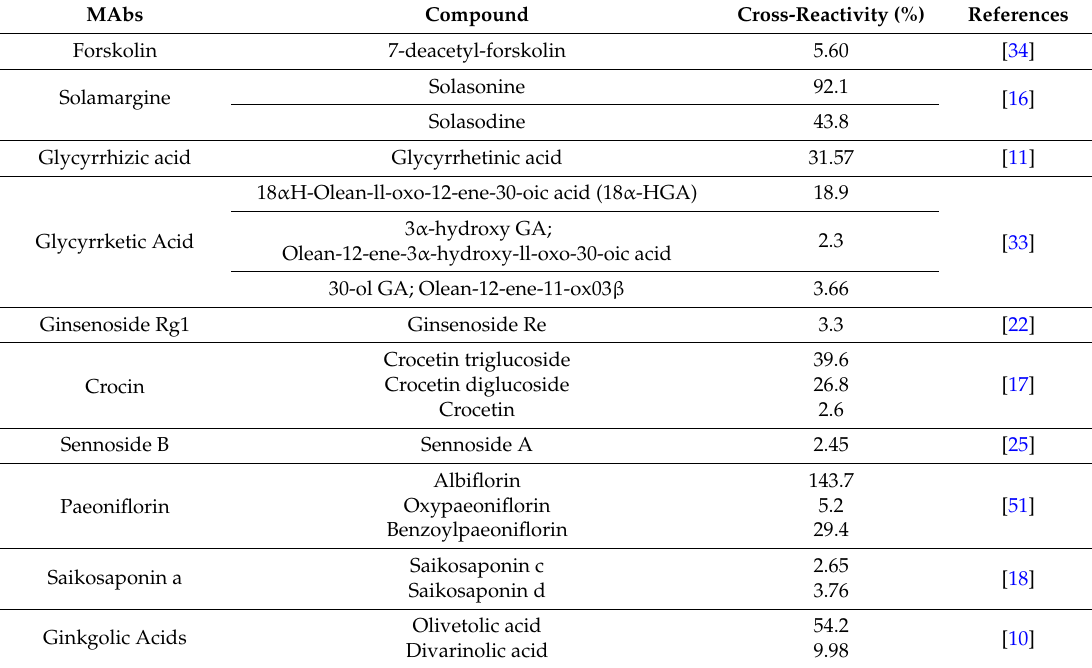
Table 3. Cross-reactivity (%) of anti-MPNP MAbs (related compounds with cross-reactivity greater than 2% were extracted from the original references and displayed in this table). The cross-reactivity of the MAbs against various compounds was evaluated using the Weiler and Zenk’s equation [50]: × 100. Cross − reactivity ( % ) = IC 50 for the target compound IC 50 for related compound under investigation